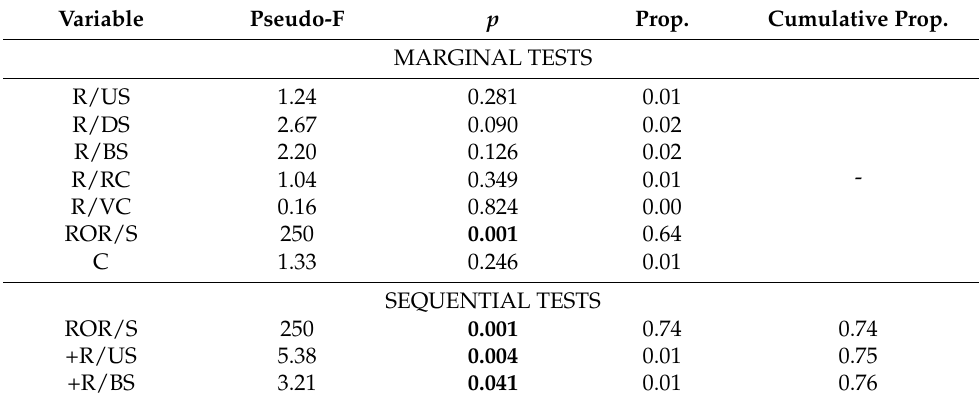
Table 2. Marginal and sequential tests of the relationships between the response variable (rill erosion) and individual geometric characteristics and soil covers in four road types using matched resemblance matrices (DISTLM) (Hell í n, Central-Eastern